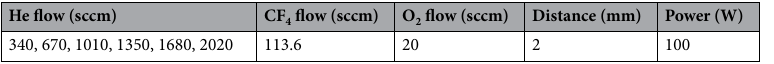
Table 3. He flow rate as processing variable.